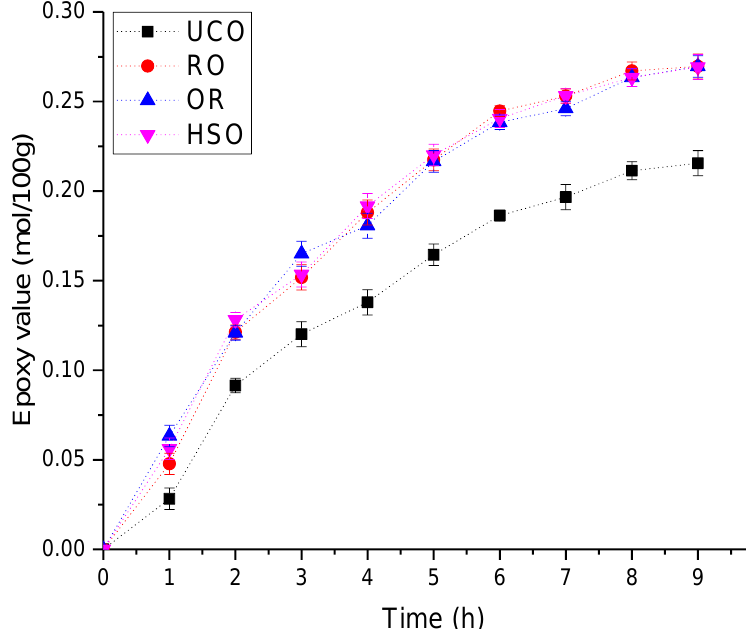
Figure 4. The change in Eval of the oils during the epoxidation process.